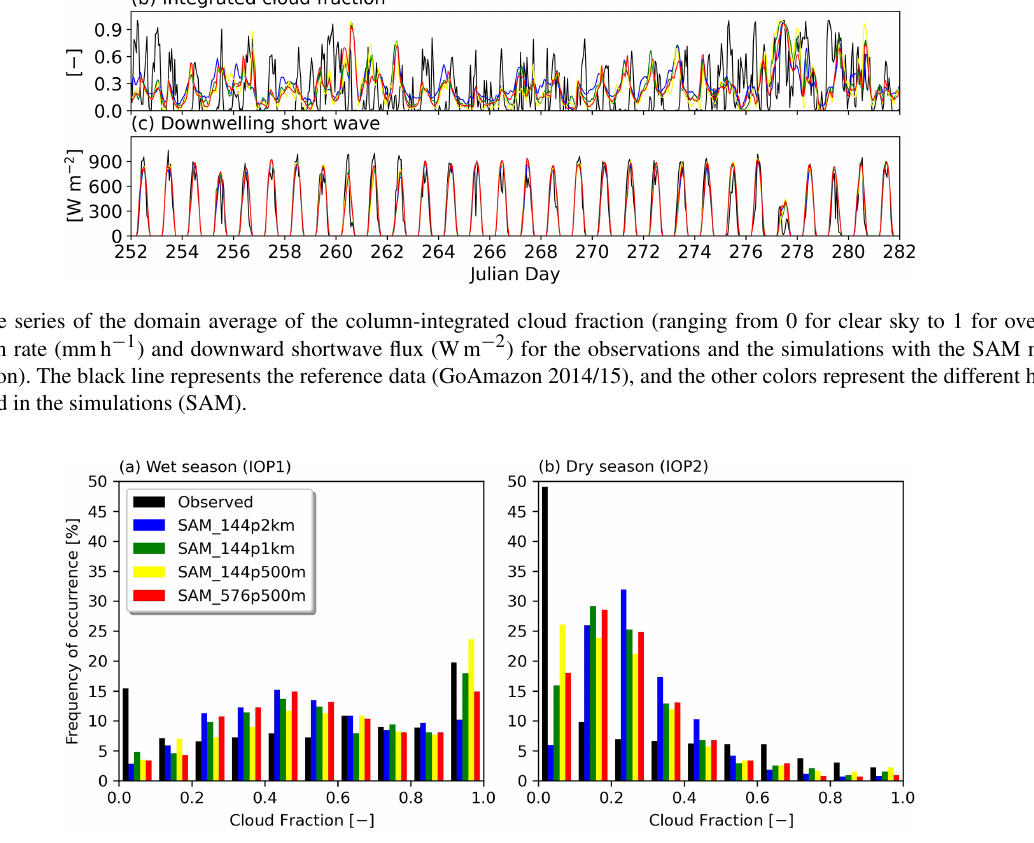
Figure 4. Histogram of the integrated cloud fraction distribution (clear sky 0 and cloudy sky 1) for the observed and simulated data with the SAM model in different resolutions for IOP1 (a) and IOP2 (b)